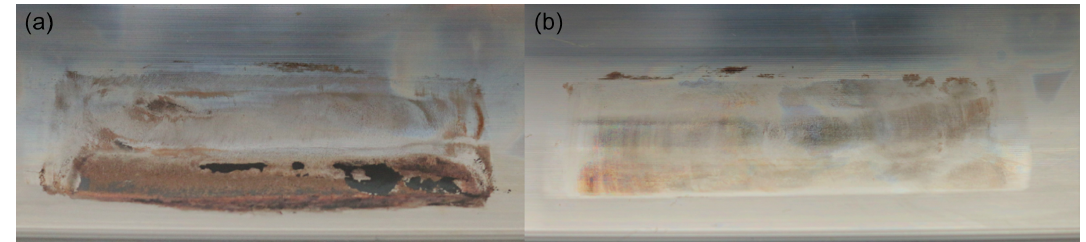
Figure 8. Two wear marks with 2.5 ◦ amplitude (a) tested with 5 ◦ s − 1 (ID III) and (b) tested with 0.8 ◦ s − 1 (ID IV).